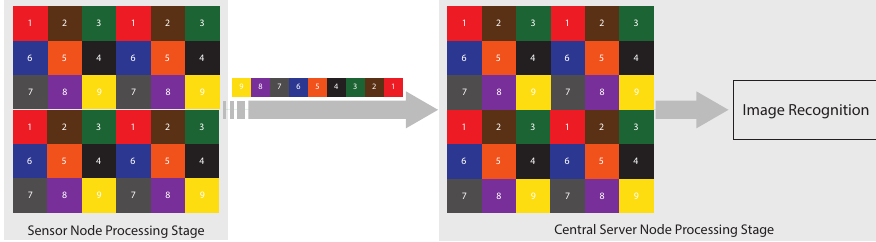
Figure 6. WVSN with standard image